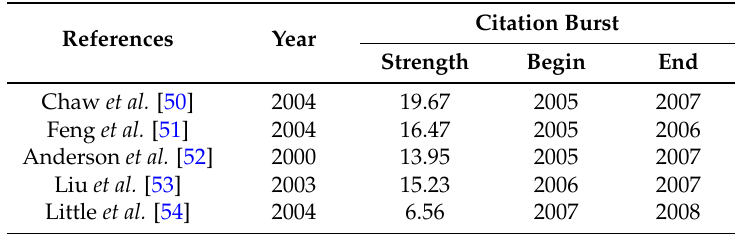
Table 5. Representative references with the strongest citation bursts.